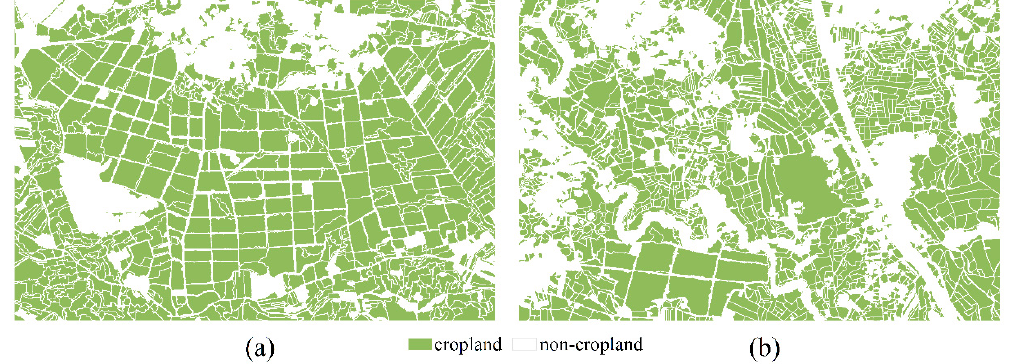
Figure 6. Cropland fields extracted by the object-based GP in Area 1 ( a ) and Area 2 ( b ).